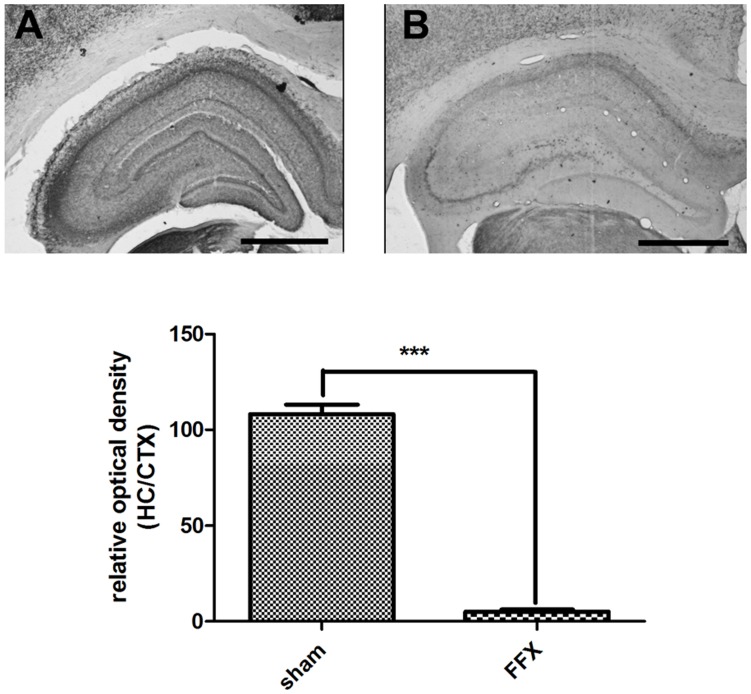
Example of histological slices verifying the effect of fimbria-fornix lesioning on hippocampal cholinergic system.In the fimbria-fornix lesioned animals (B) a substantial loss of cholinergic innervations was revealed by AChE staining compared to sham operated animals (A). The scale bar represents 1.0 mm and the columns and error-bars mean ± SEM, *** P<0.001, (sham, n = 12; FFX, n = 12).